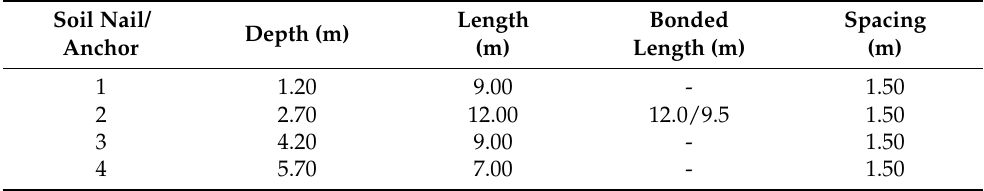
Table 3. Design parameters of composite soil nailed retaining structure.